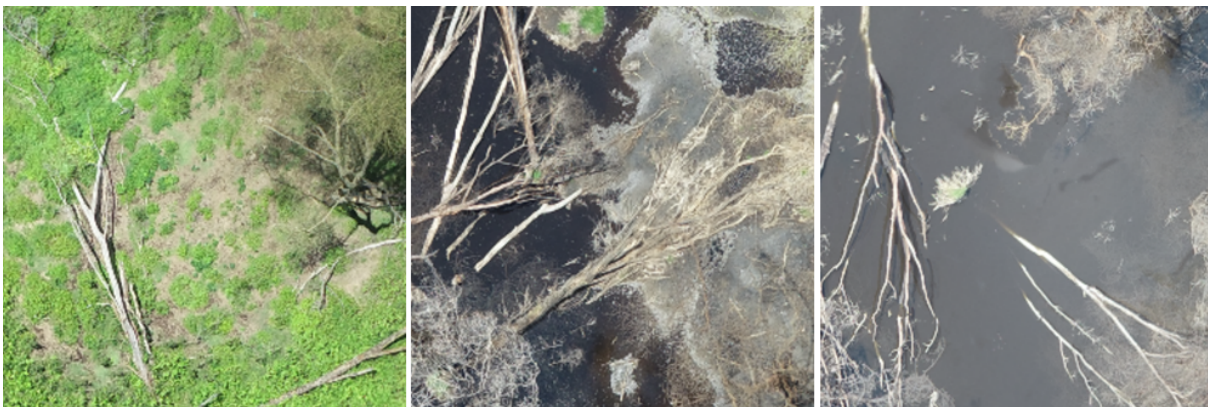
Figure 3. The three sample classes and numbers of annotations in the dataset: from left to right, dead trees on land (2,514 boxes), dead trees on mudflat (2,077 boxes), and dead trees on water (2,999